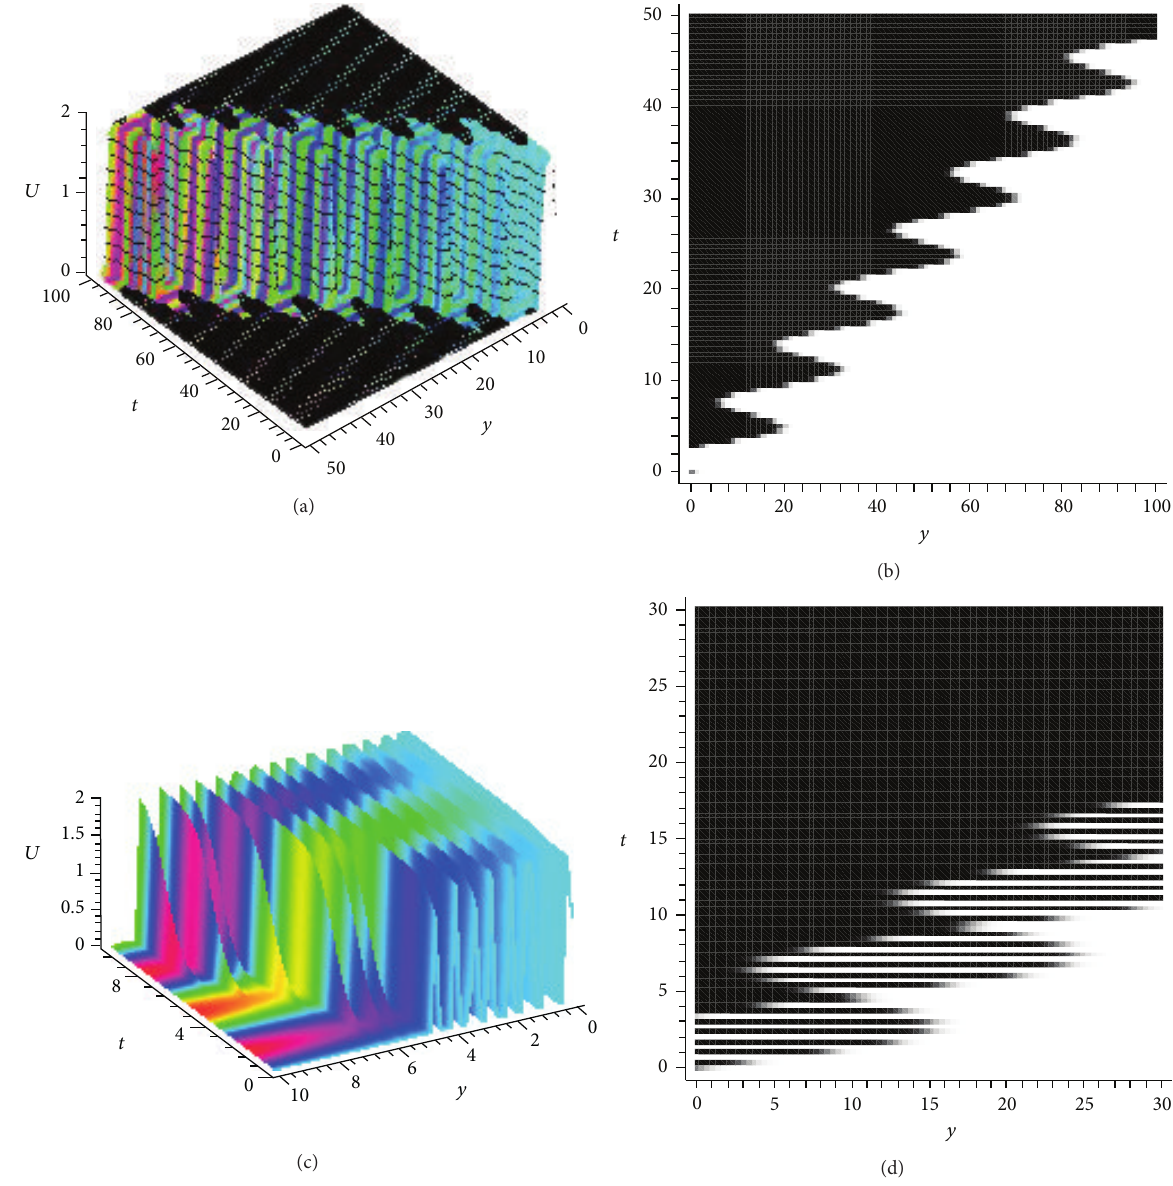
Figure 2: Evolutional behavior of 𝑈 2 describes kink soliton solution with periodic moving boundary 𝑠(𝑡) = 10 sin ( V 𝑡) : (a) V = 1 ; (b) density plot of (a); (c) V = 10 ; (d) density plot of (c).